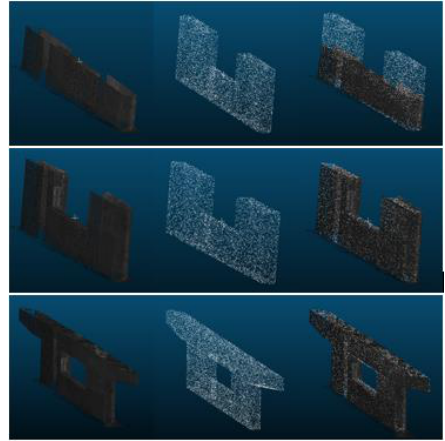
Figure 7. The as-built point cloud, virtual point cloud and registration results for case 1, 2 and 3 of Pier 1 (Left to right, top to bottom respectively).